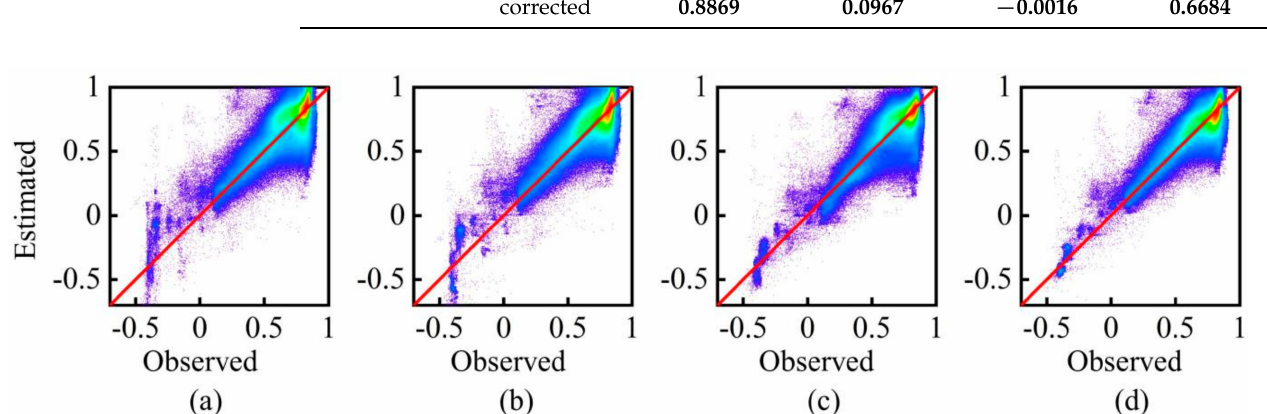
Figure 12. Scatter plots of NDVI and Landsat NDVI observations on 2 August 2018, estimated using various methods: ( a ) FSDAF, ( b ) bias-corrected FSDAF, ( c ) STARFM, and ( d ) bias-corrected STARFM (the red line is the 1:1